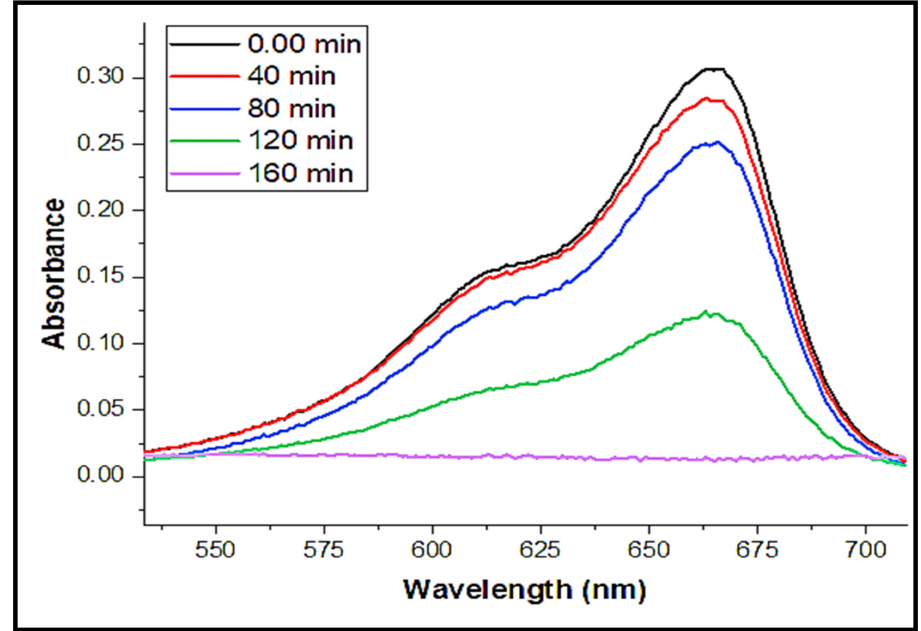
Figure 9. UV-Vis spectra show the gradual photocatalytic deterioration of MB